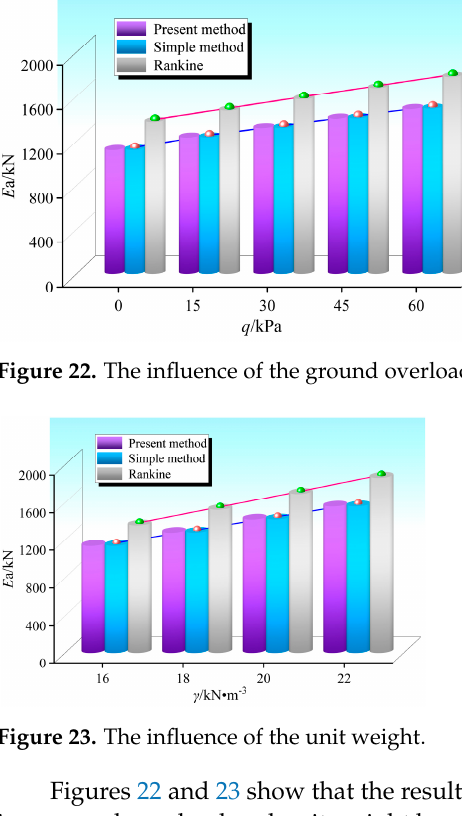
Figure 21. The influence of structure-soil friction angle.